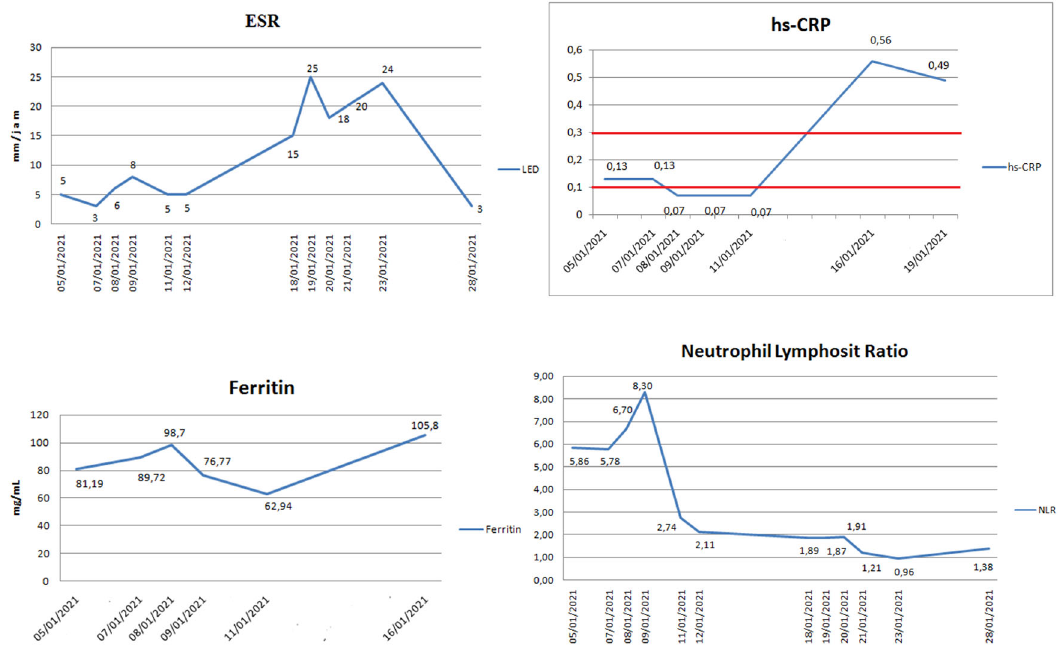
Figure3.Erythrocytesedimentationrate(ESR),C-reactiveprotein(CRP),Ferritin,andNeutrophil-Lymphocyte Ratio (NLR) of the